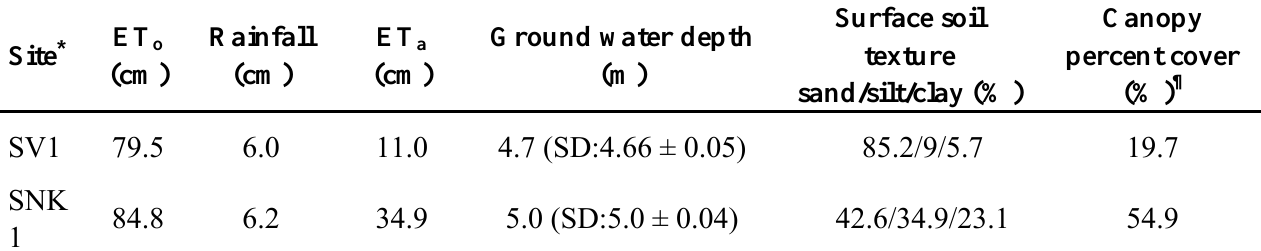
Table 2. Major soil-plant and atmospheric characteristics of Spring Valley 1 site (SV1) and Snake Valley 1 site (SNK1).